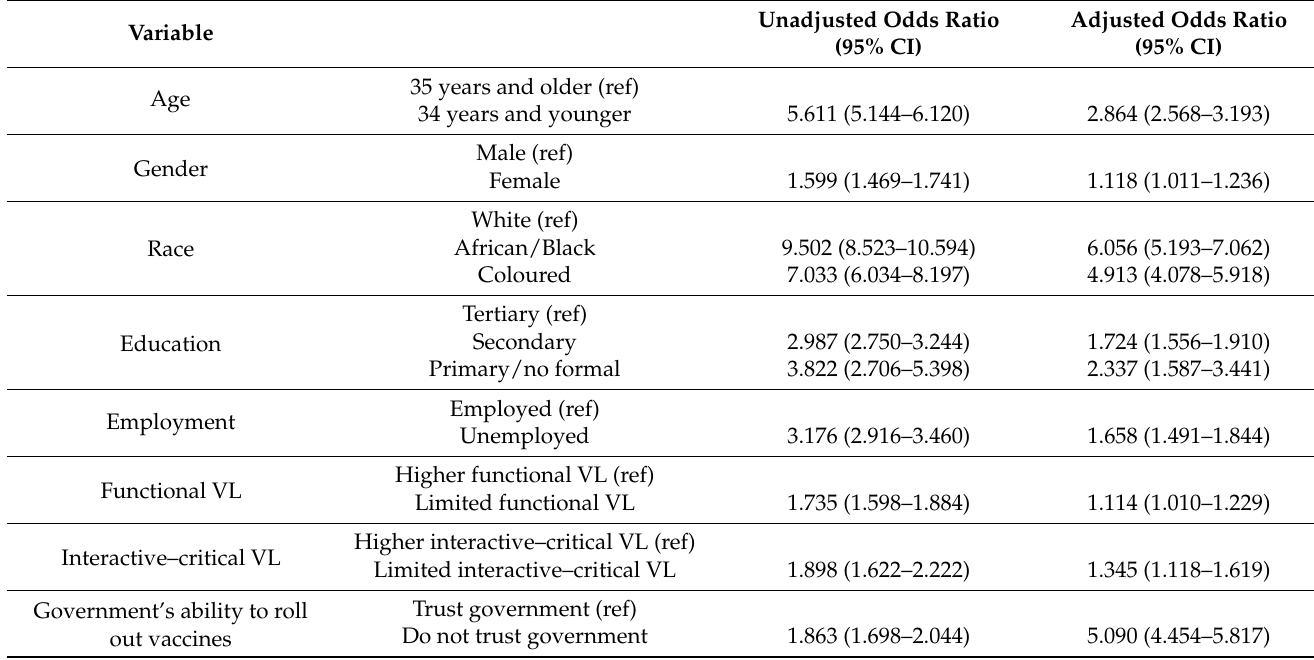
Table 4. Factors associated with non-uptake of COVID-19